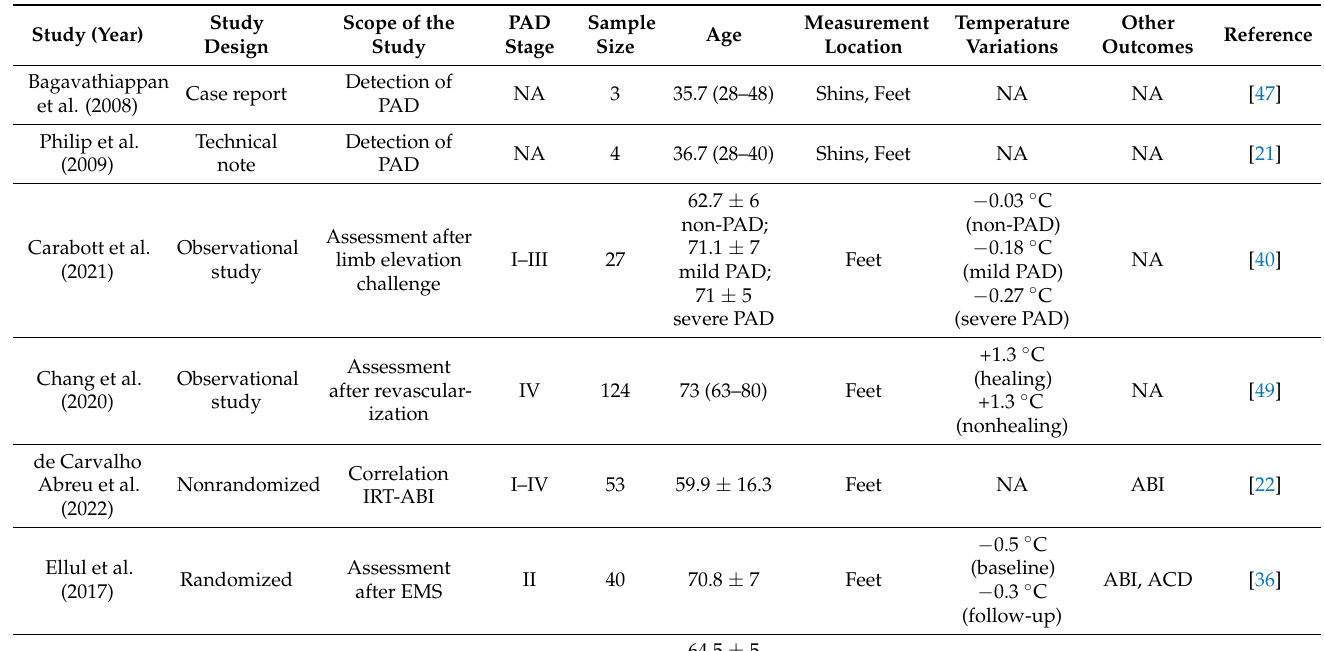
Table 2. The different models of thermography devices employed in the included